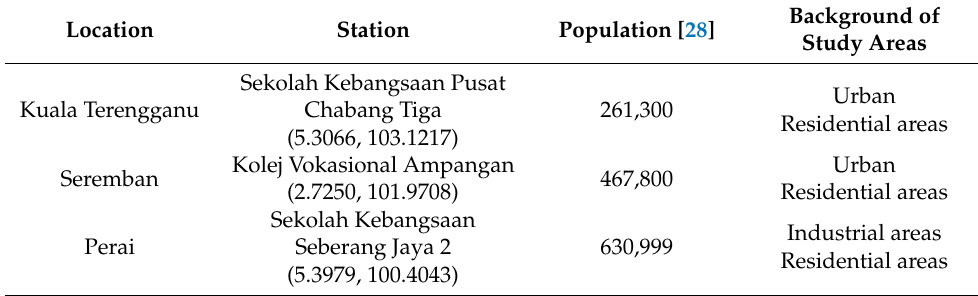
Table 1. Details of Study Areas.